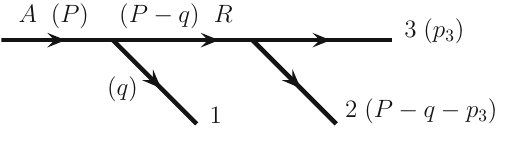
Fig. 1 Tree level diagram for the process A → 1 + 2 + 3 mediated by a resonance R that decays into particles 2 and 3. In brackets the momenta of the particles